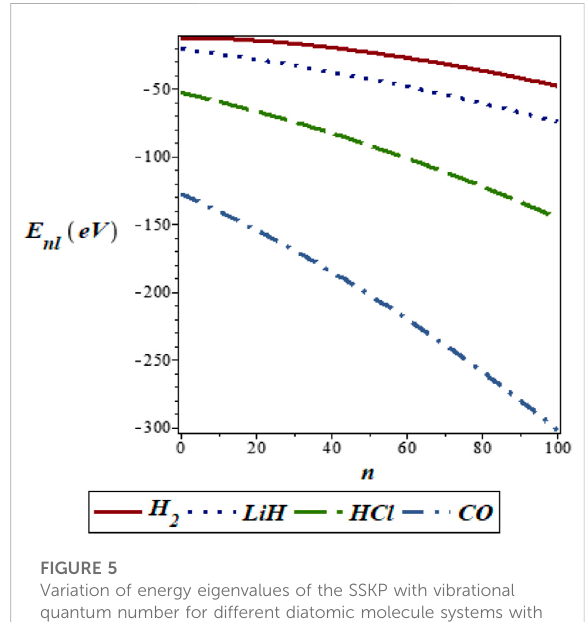
FIGURE 3 Variation of energy eigenvalues of the SSKP with screening parametersfordifferentdiatomicmoleculesystemswith n =2and l = 1.